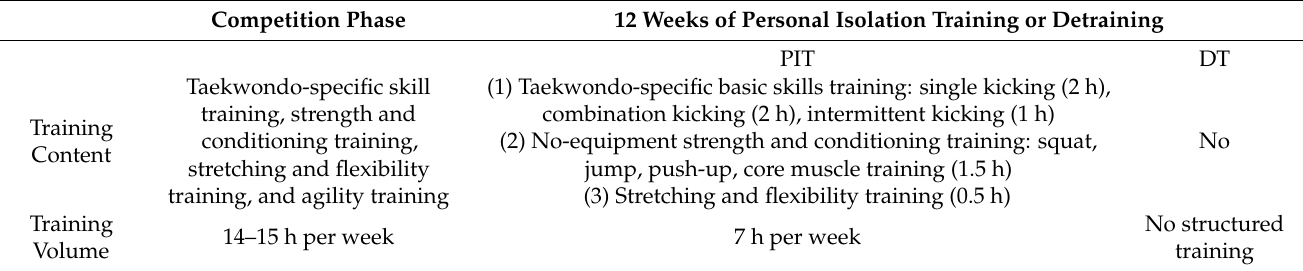
Table 1. The PIT and DT training